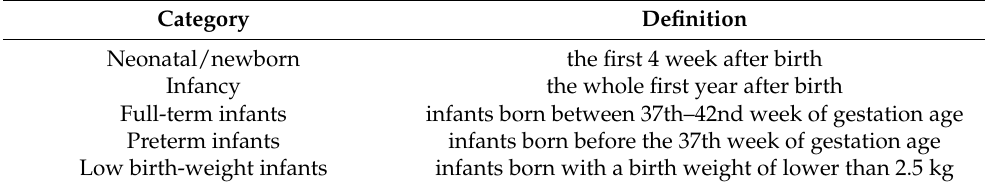
Table 1. Nomenclature for newborn babies. Category Definition Neonatal/newborn